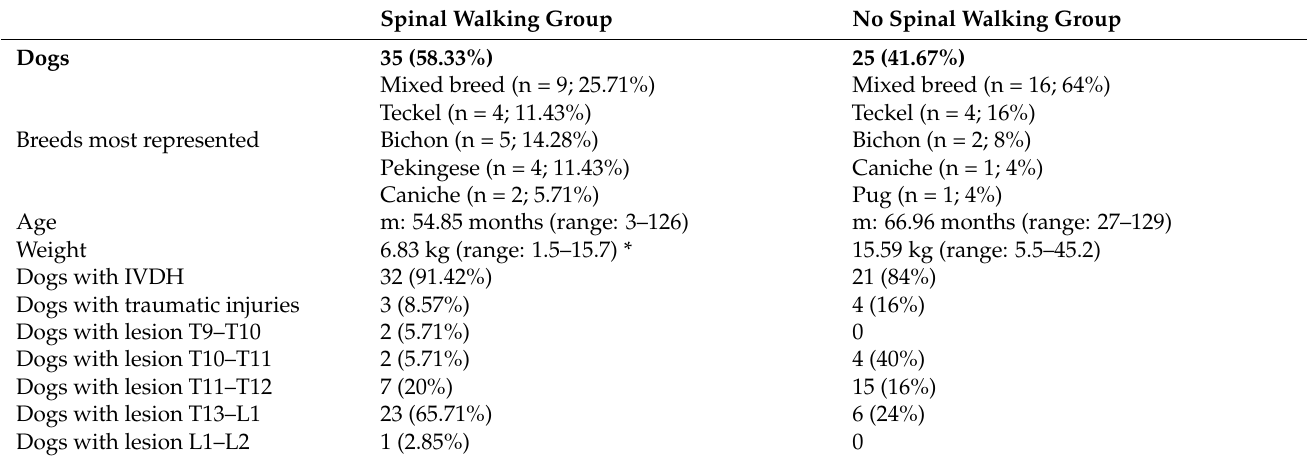
Table 2. The spinal walking and no spinal walking groups (n = 60).